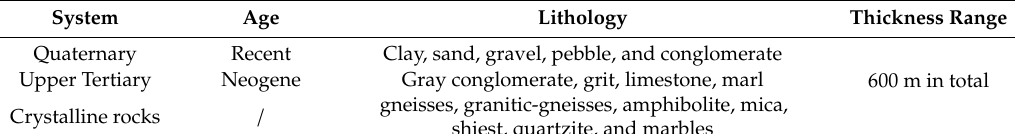
Table 1. Geological Condition of the Kabul Basin [16,20].